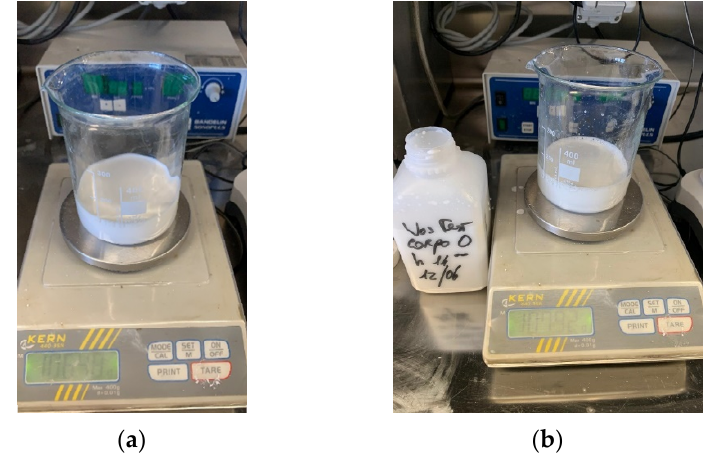
Figure 9. Nanofluid dispersion during weight measurements in lab. ( a ) Density = 1065 g/L before pumps switched on. Concentration (1.7%); ( b ) Density = 1079 g/L after 29 h of running pumps. Concentration (2.0%).